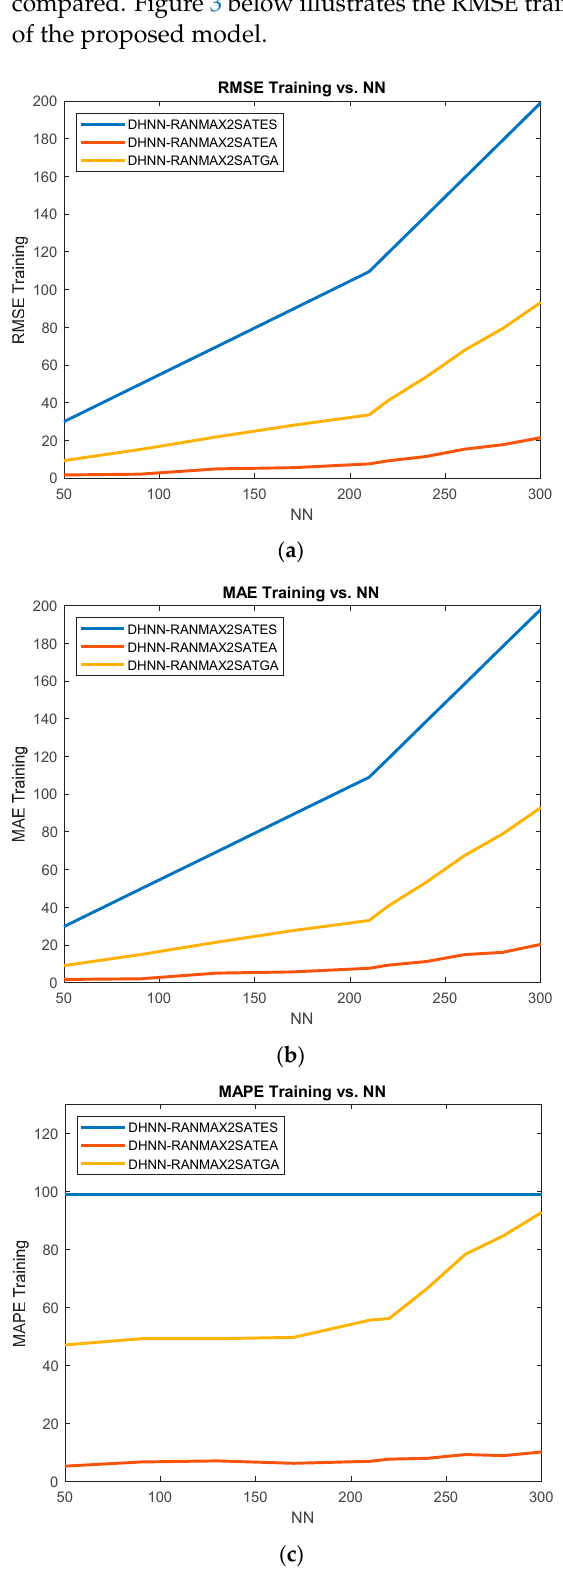
Figure 3. ( a ) RMSE training for DHNN-RANMAX2SAT; ( b ) MAE training for DHNN-RANMAX2SAT; ( c ) MAPE training for DHNN-RANMAX2SAT. (i)